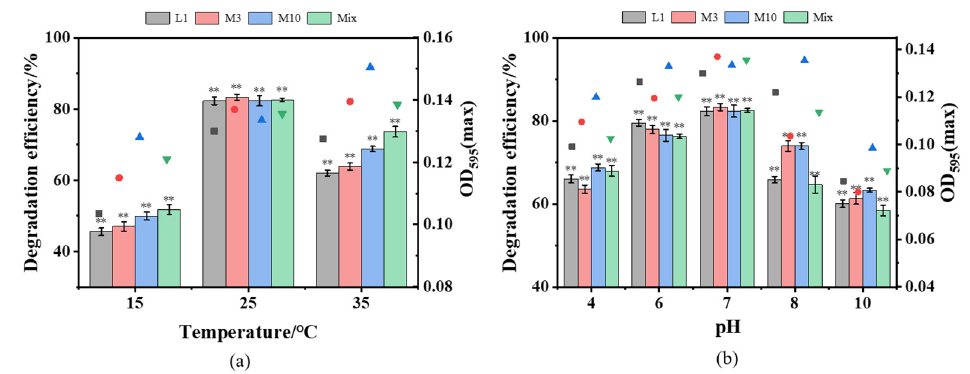
Figure 5. Tolerance of strains to temperature and pH. The growth of strains (scatter chart) and the yield of degradation (bar chart) carried out on various ( a ) temperature and ( b ) pH. ** represents p < 0.01.